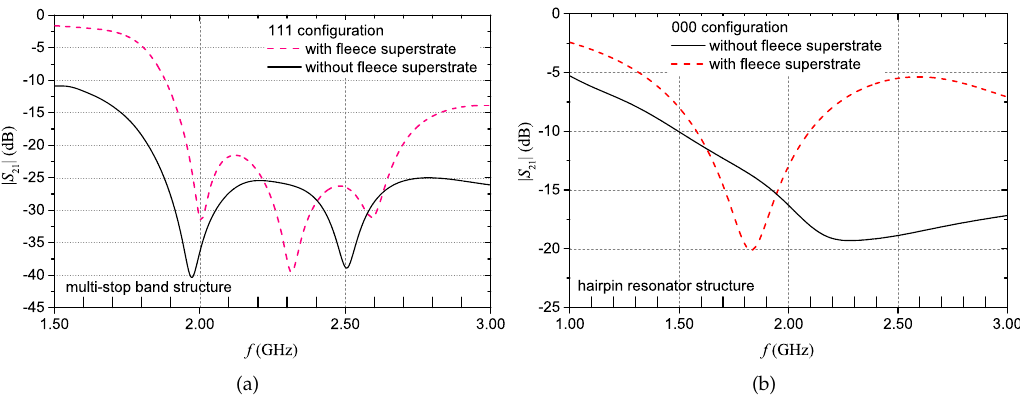
Figure 17. | S 21 | simulation results obtained placing the devices in contact with the human body: for the multi-stopband structure ( a ) and for the hairpin resonator ( b ), with and without fleece